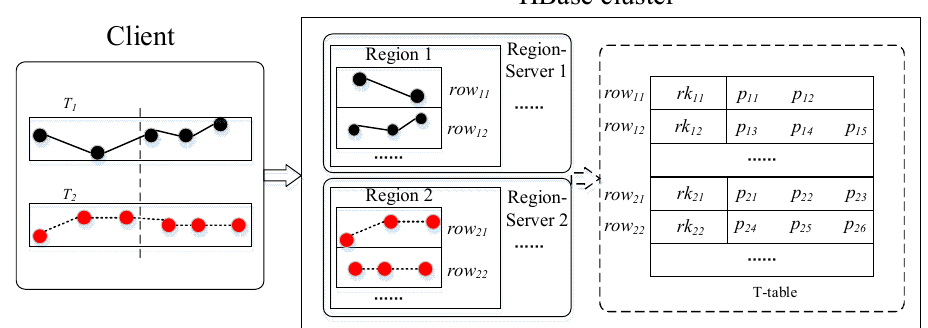
Figure 2. Storage process of trajectory data in T-table.